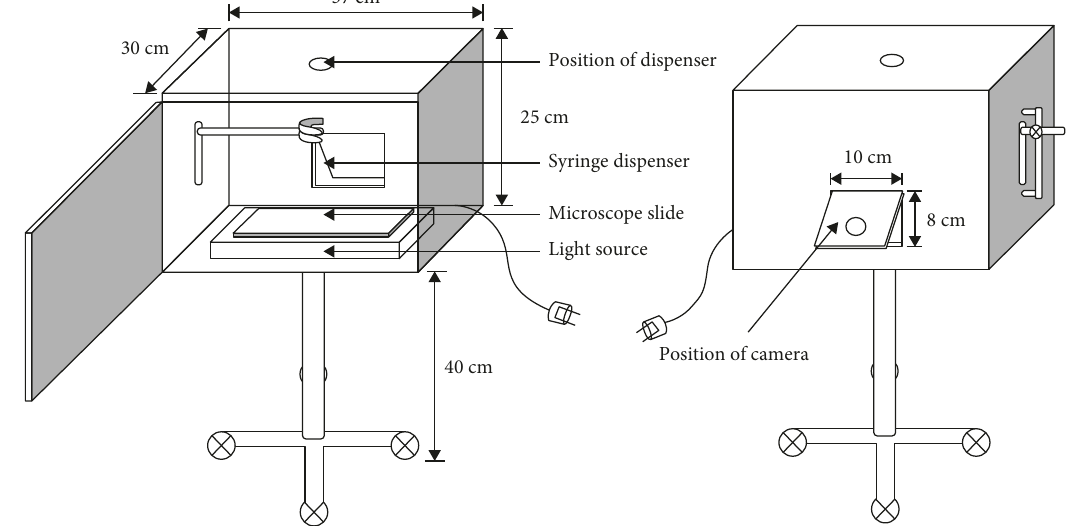
Figure 2: Illustration of the computer vision system setup for capturing the image of frying